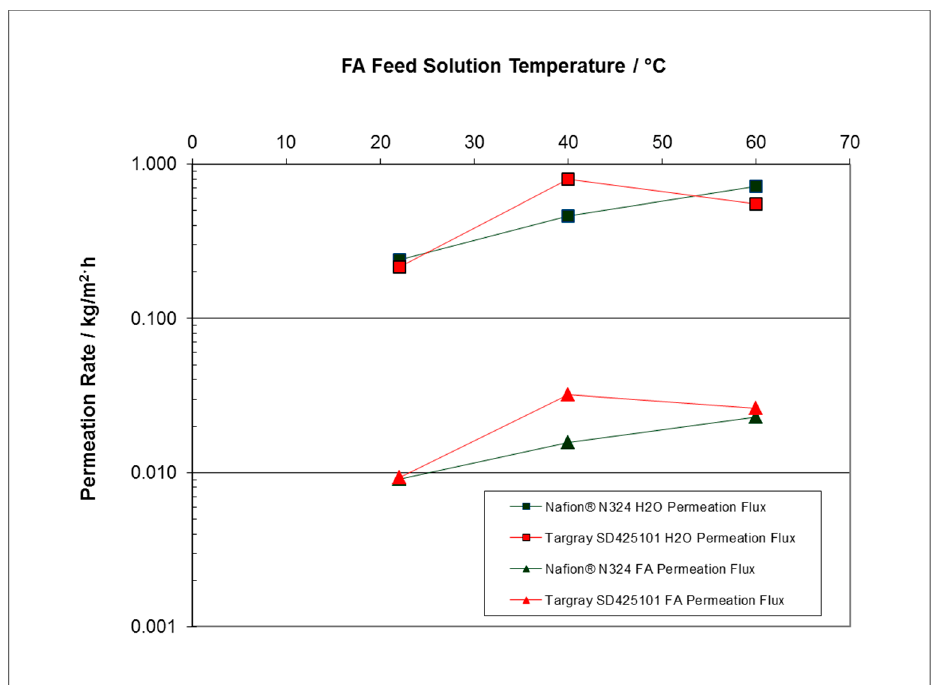
Figure 2. Comparison plot of the permeation rates of H 2 O and FA for Nafion ® N324 and Targray membranes using a 10 wt% FA feed solution at pervaporation system operating temperatures of 22, 40, and 60 °C.